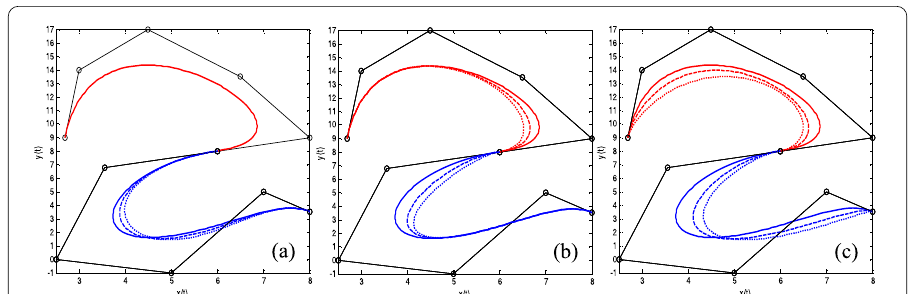
Figure 7 Examples of shape adjustment of G 1 smooth continuity.